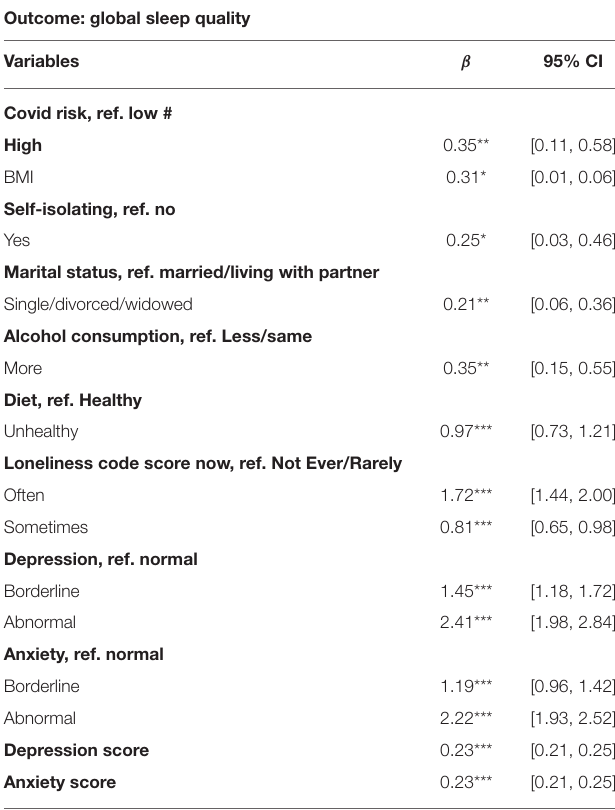
TABLE 2 | Factors associated with sleep quality during the early COVID-19 lockdown (April–June 2020). Outcome: global sleep